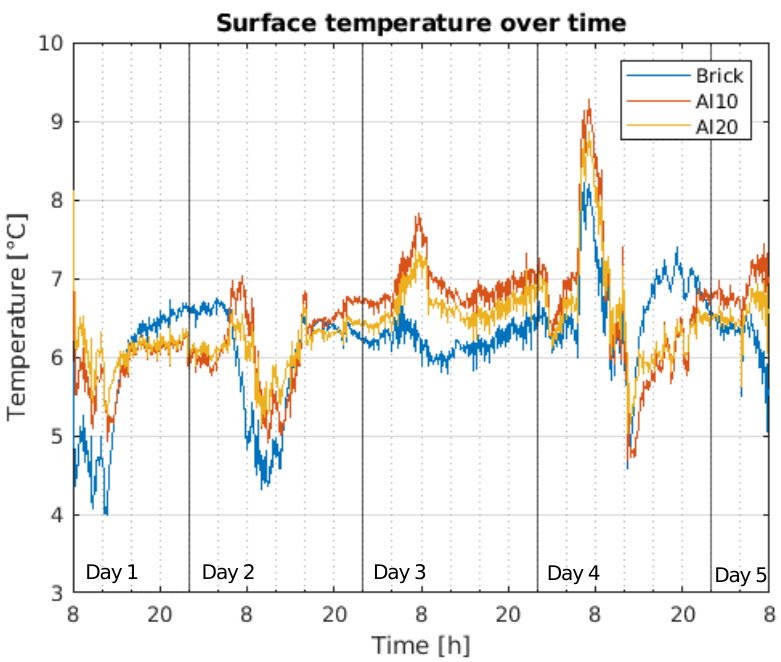
Figure 8. Average surface temperature for the ROIs depicted above. Noticeable is the greater temperature difference of the Al10 plate vs the Al20 plate, caused by the lower thermal mass.